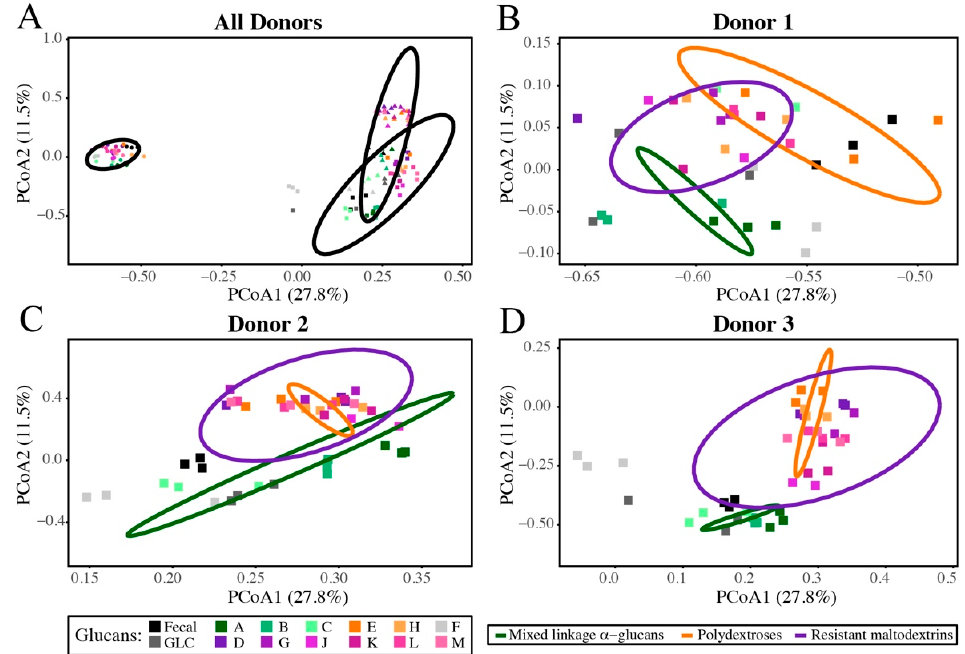
Figure 5. Principal coordinate analysis (PCoA) plot displaying differences in β -diversity, as calculated using the Yue and Clayton theta metric. Shapes represent different donors’ microbiota (all donors, ( A ); donor 1, ( B ); donor 2, ( C ); and donor 3, ( D )) and colors represent the distinct glucans, within their glucan categories (mixed linkage α -glucans, greens; polydextroses, oranges; resistant maltodextrins, purples). Ellipses drawn based on 99% confidence